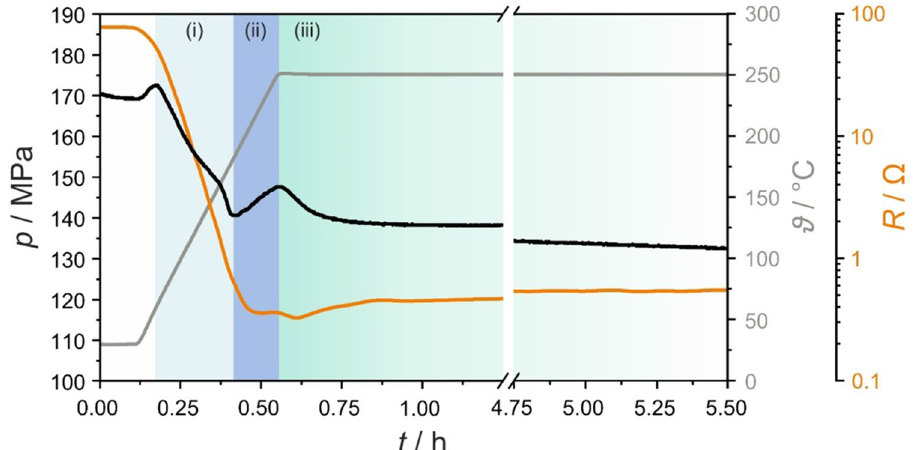
Figure 4. Synthesis pTR -diagram for Li 4 PS 4 I from glassy 1.5Li 2 S–0.5P 2 S 5 –LiI using a hot-press setup. Sample temperature, pressure and resistance versus the time are shown as gray, black and orange lines, respectively. Light blue, blue and green shaded areas indicate (i) precursor softening, (ii) nucleation of Li 4 PS 4 I and (iii) crystallization.